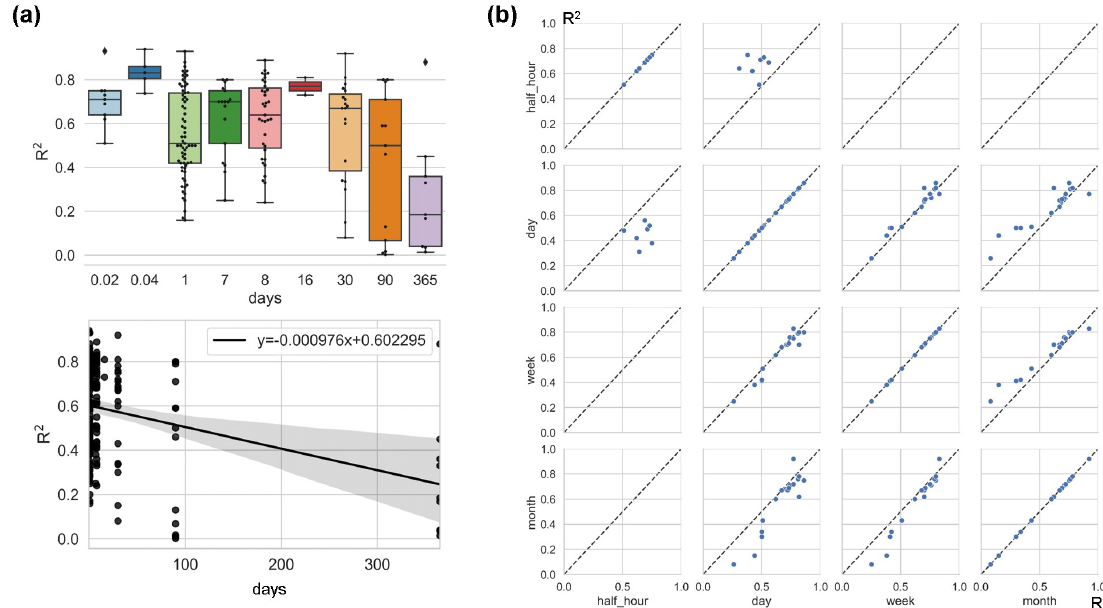
Figure 6. Differences in model accuracy ( R 2 ) at different timescales across studies with the linear regression between R 2 and timescales (a) and comparison of the model accuracy ( R 2 ) of selected pairs of timescales within individual studies (b) . All model records were included in (a) , while studies that used multiple timescales (with other model characteristics unchanged) were included in (b) . Timescales: 0.02d (half-hourly), 0.04d (hourly), 30d (monthly), and 90d